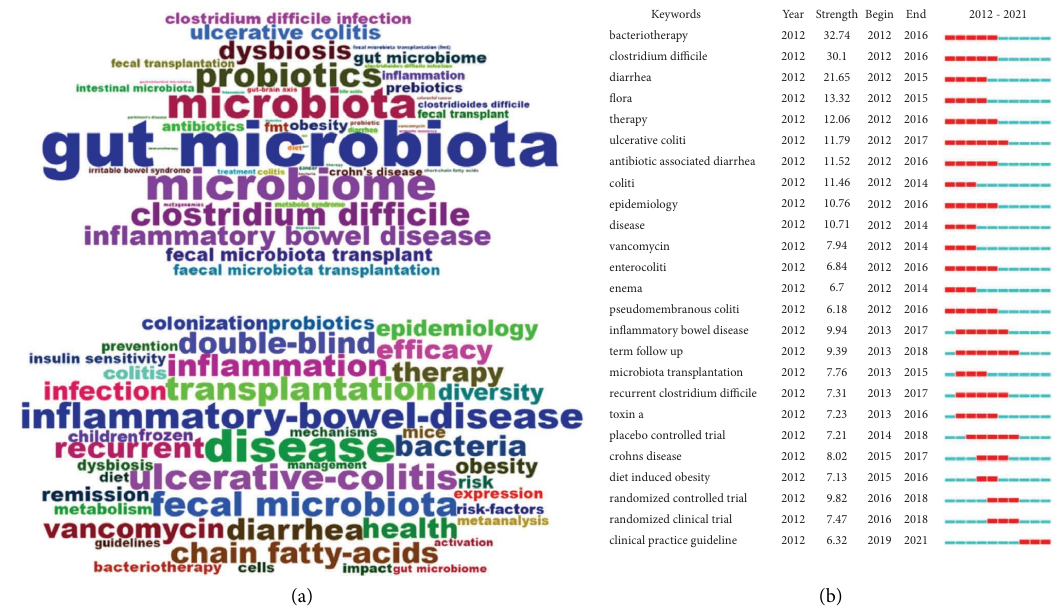
Figure 6: (a) Common FMT-related author keywords (above) and keywords plus (below). (b) Te 25 bursts keywords (the years in green and red suggest that the keywords have less and greater efects,